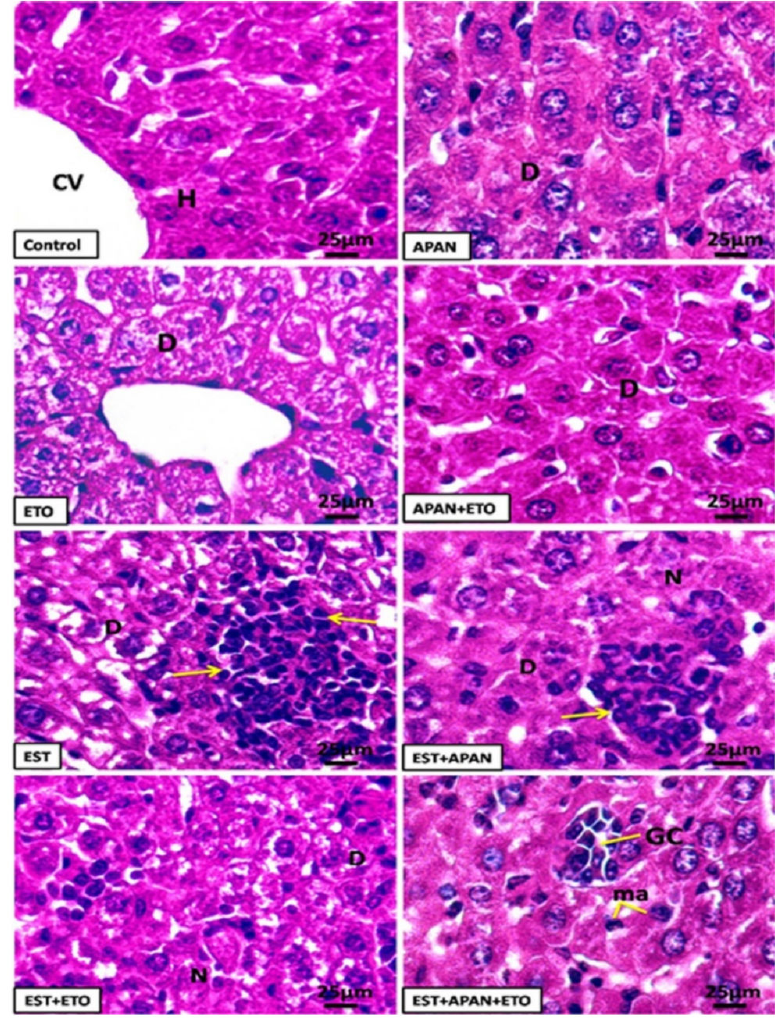
Figure 7. Photomicrographs of liver H and E sections of female mice in the different experimental groups. The control group reveals a normal structure of hepatocytes (H) with normal central veins (CV). APAN, ETO, and APAN+ETO groups display mild cytoplasmic vacuolization and degeneration of hepatocytes (D). EST group shows a strong degeneration with cytoplasmic vacuolization (D) and marked inflammatory cells infiltrations with irregular hyperchromatic tumor cell population (thin arrows). EST mice treated with APAN reveal a modest degree of improvement in hepatocyte damage, inflammatory cell infiltrations with some irregular hyperchromatic tumor cells population (thin arrows), giant cell (GC), diffuse necrosis of hepatic tissue (N), and mild degeneration of hepatocytes (D). EST mice treated with ETO show mild diffuse necrosis of hepatic tissue (N), degeneration of hepatocytes with a marked cytoplasmic vacuolization (D), and giant cell (GC). EST mice treated with both APAN+ETO reveal a significant degree of improvement in hepatocyte damage with giant cell (GC) and enlarged macrophage cells (ma). Scale bar, 25 µ